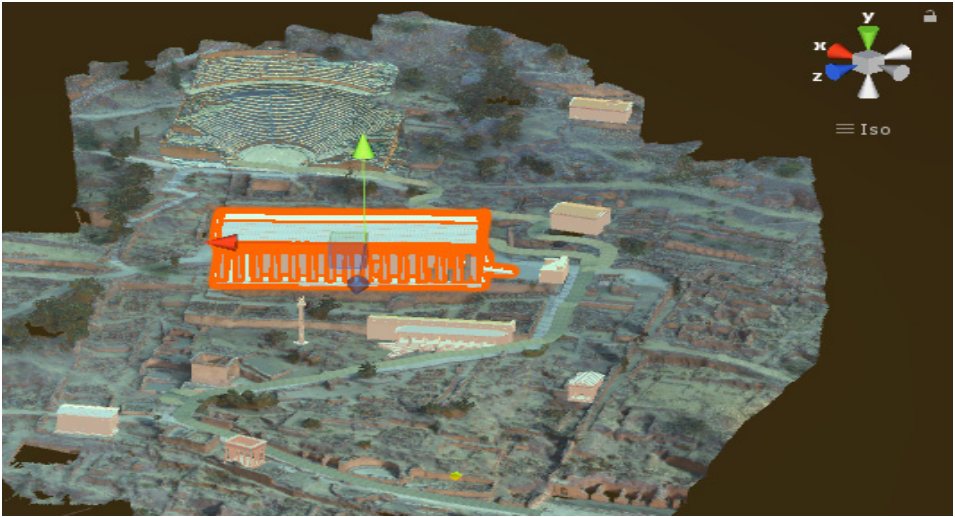
Figure 4. Import of 3D reconstructed buildings from the museum archive to Unity 3D (© Authors).